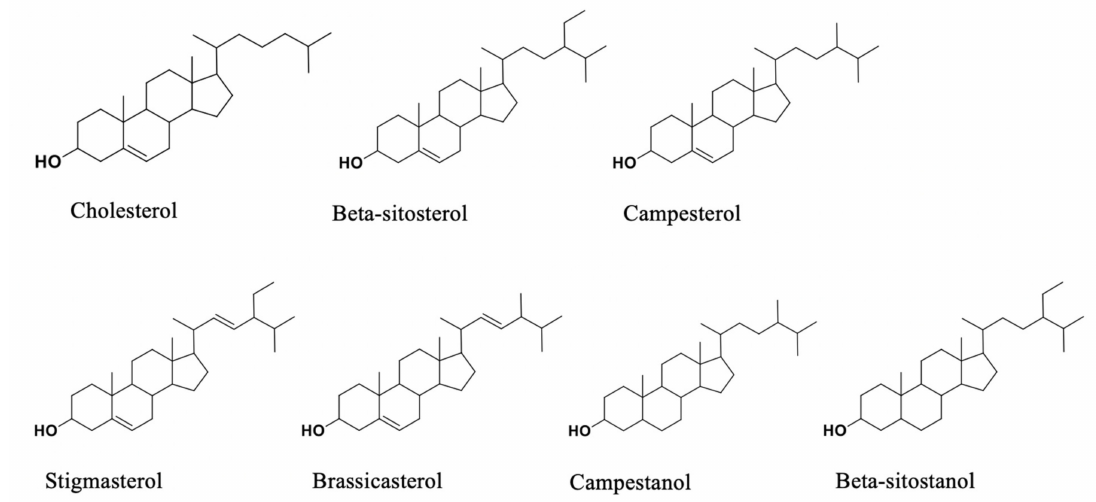
Figure 1. Cholesterol and some phytosterols’